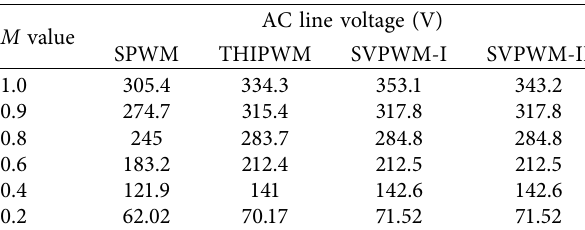
Table 9: AC line voltage value at various values of M .